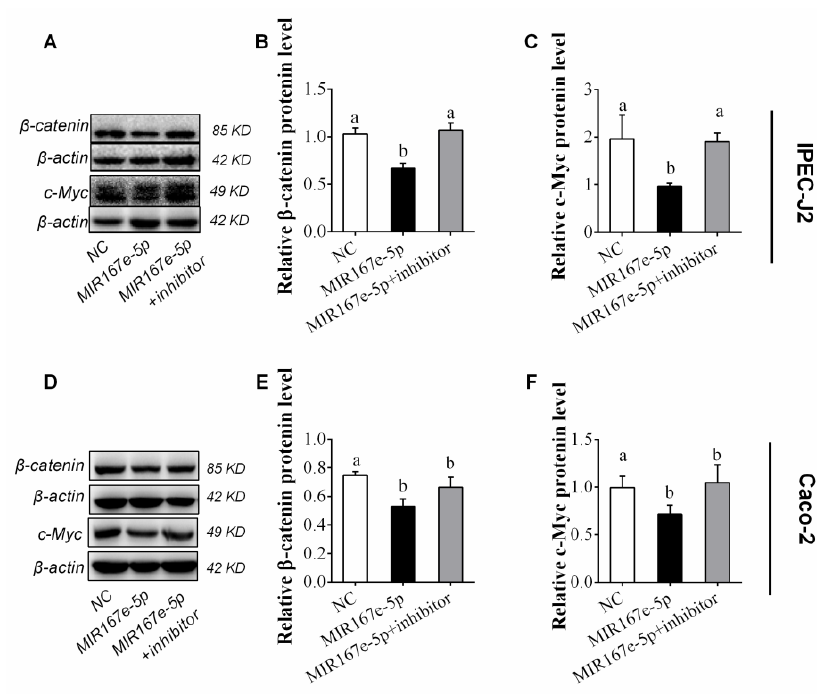
Figure 4. MIR167e-5p suppresses β -catenin and c-Myc protein expression. ( A – C ) Western blot was used to evaluate β -catenin ( A , B ) and c-Myc ( A , C ) protein levels in IPEC-J2 cells after transfection with NC, MIR167e-5p, or MIR167e-5p + inhibitor ( n = 6; LSD tests). ( D – F ) β -catenin ( D , E ) and c-Myc ( D , F ) protein levels in Caco-2 cells after transfection with NC, MIR167e-5p, or MIR167e-5p + inhibitor ( n = 6; LSD tests). The same superscripts denote non-significant di ff erences ( p > 0.05), di ff erent superscripts denote significant di ff erences ( p < 0.05).